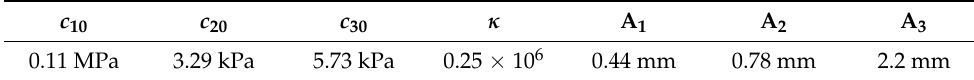
Table 2. Identified parameters